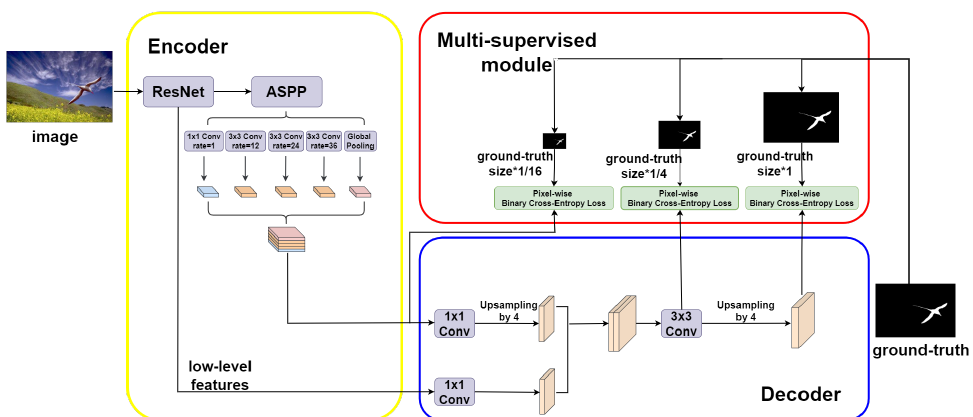
Figure 2. The overview of the proposed Multi-Supervised Encoder–Decoder (MSED) architecture for the image forgery detection and localization task, which contains three sub-modules: encoder (yellow outer box), decoder (blue outer box), and multi-supervised module (red outer box). In the multi-supervised module, we calculate pixel-wise Binary-Cross Entropy (BCE) loss between the ground-truth mask after interpolation and the encoded feature map after the encoder and each upsampling, which is highlighted by the green cubes.